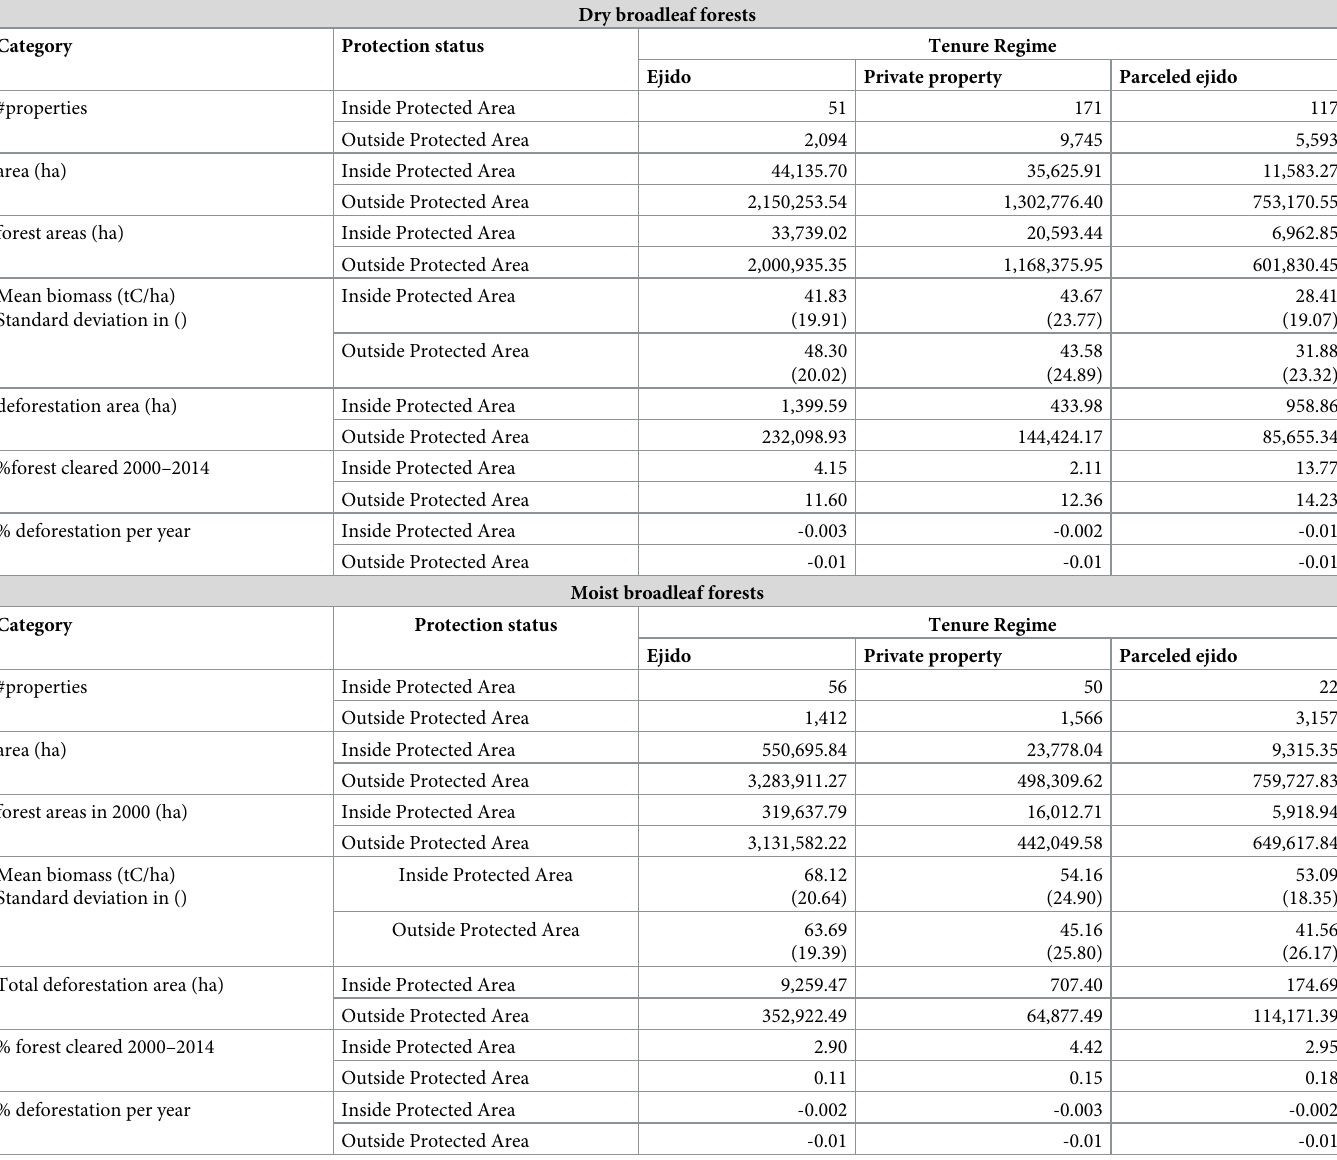
Table 1. Descriptive spatial statistics for tenure regimes and ecosystem types inside and outside protected areas (PA). The unprotected pieces of protected properties have been excluded from the calculations in this